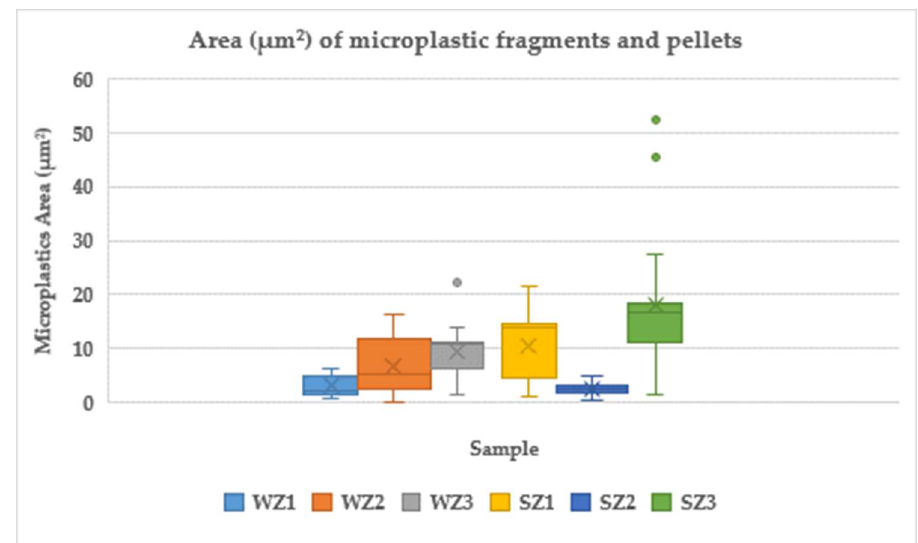
Figure 4. Area ( µ m 2 ) of microplastic fragments and pellets found in all six samples. Box plots depict range of particle areas with top whisker equal to the 90th percentile of areas, top of the box equal to the 75th percentile, bar at middle of box equal to the 50th percentile, bottom of box equal to the 25th percentile, and bottom whisker equal to the 10th percentile. Dots above the top of the whisker represent large area values that occur outside the quartiles represented, showing that the biggest fragments occur at Site 3. The number of microplastic particles in each sample are Water Site 1 (WZ1: nine fragments), Water Site 2 (WZ2: 17 fragments), Water Site 3 (WZ3: 23 fragments), Sediment Site 1 (SZ1: 22 fragments, four pellets), Sediment Site 2 (SZ2: 10 fragments, zero pellets), and Sediment Site 3 (SZ3: 19 fragments, three pellets). The X inside the boxes represents the average data (WZ1: 3.03 µ m 2 , WZ2: 6.45 µ m 2 , WZ3: 9.22 µ m 2 , SZ1: 10.29 µ m 2 , SZ2: 2.55 µ m 2 , SZ3: 17.96 µ m 2 ).